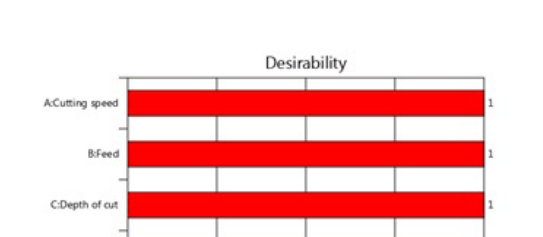
Figure 7. Ramp diagram.